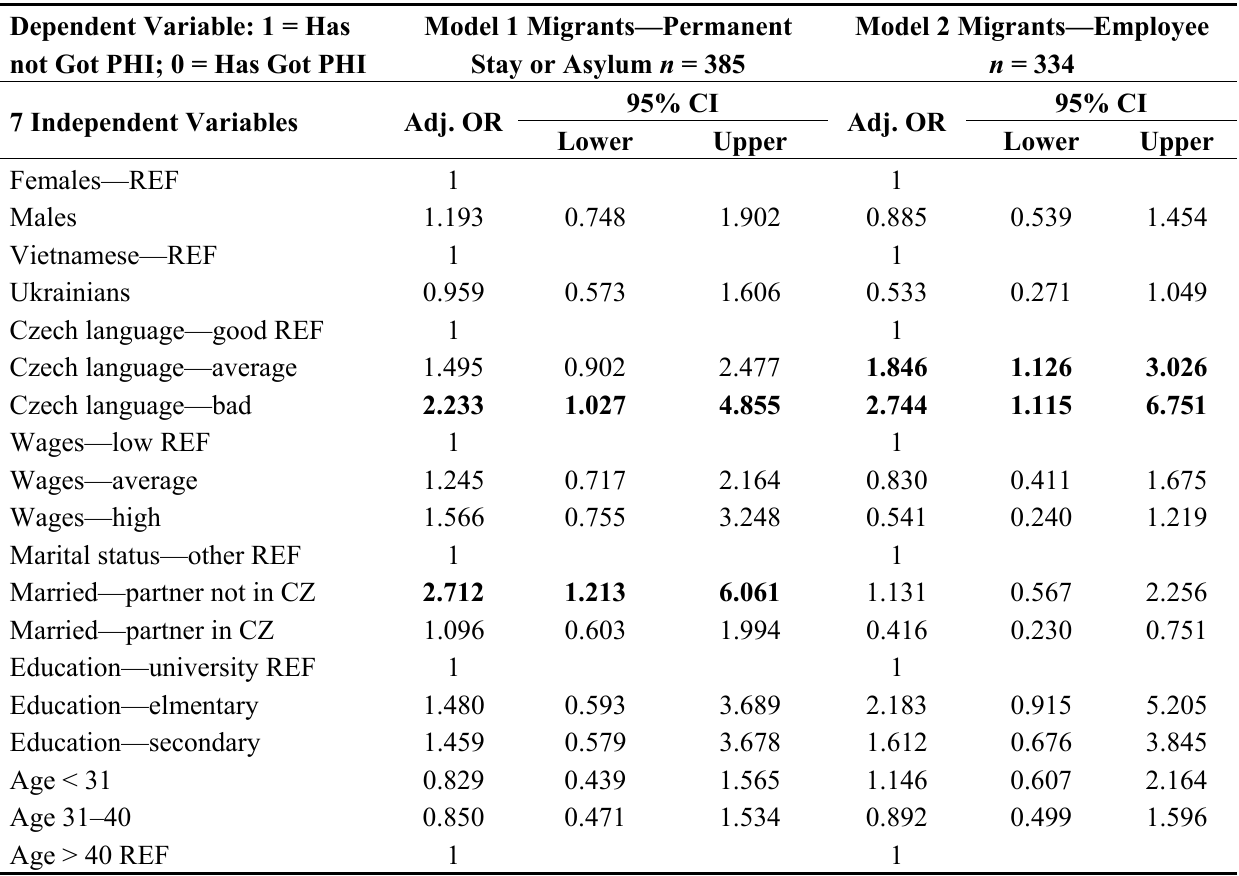
Table 2. Adjusted odds ratio and 95% CI for coverage with public health insurance for the group of immigrants entitled to